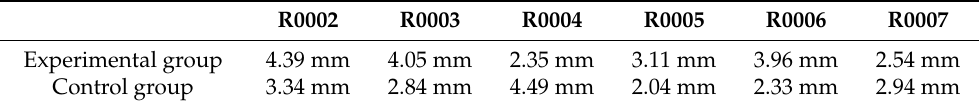
Table 10. Precipitation at effective stations in Liupan Mountain.